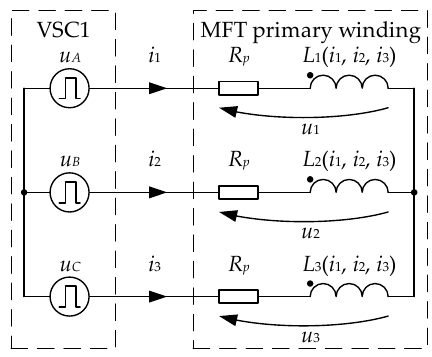
Figure 9. MFT no load test equivalent circuit model coupled with the finite element model through the nonlinear inductances L 1 , L 2 and L 3 .